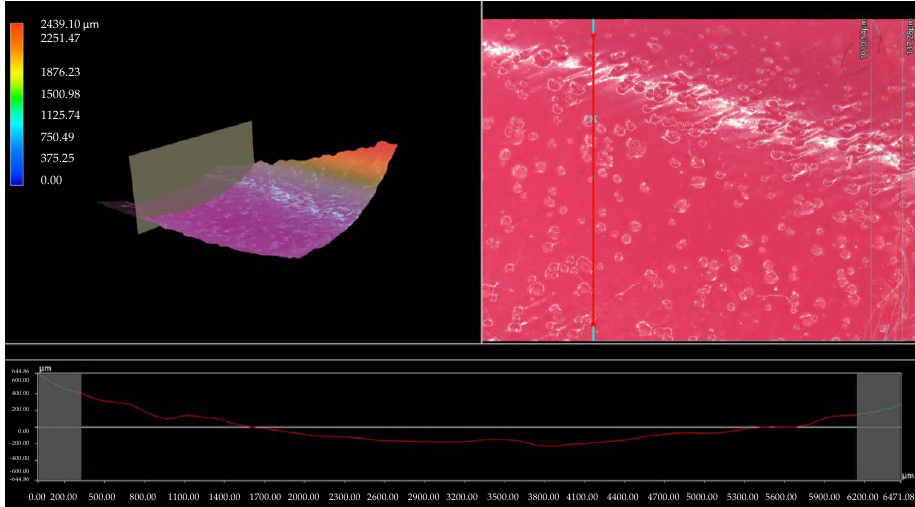
Figure 4. 3D view and the roughness profile (along the red line) of sample